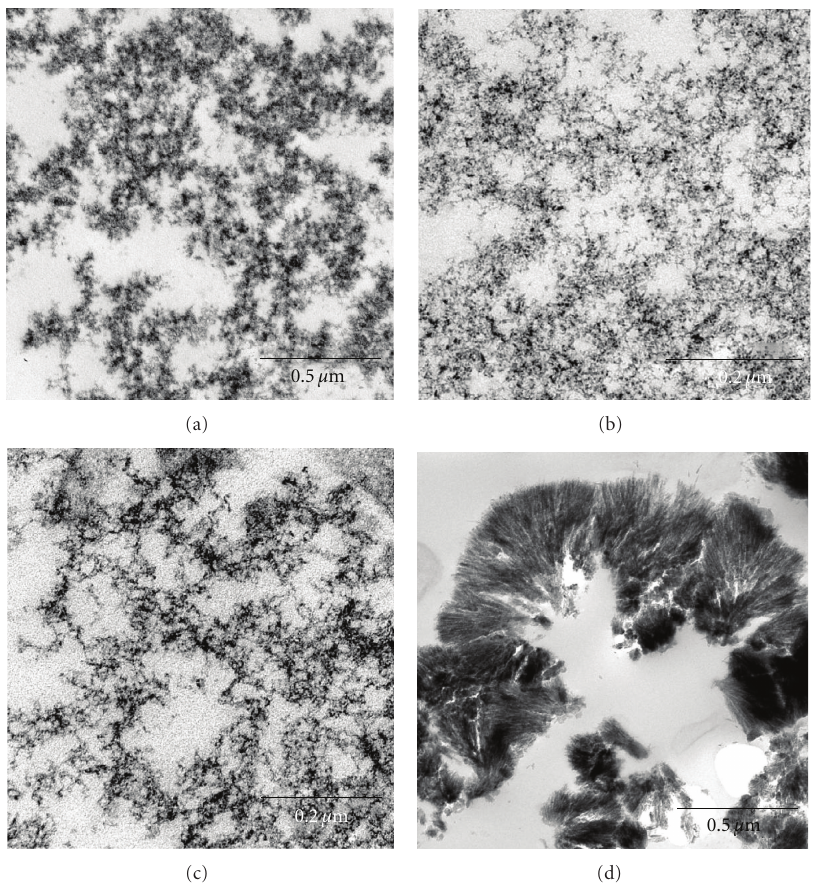
Figure 9: TEM images of TiO 2 nanoparticles of di ff erent crystalline modification in ultrathin sections: amorphous (a), anatase (b), brookite (c), and rutile (d). Ultrathin